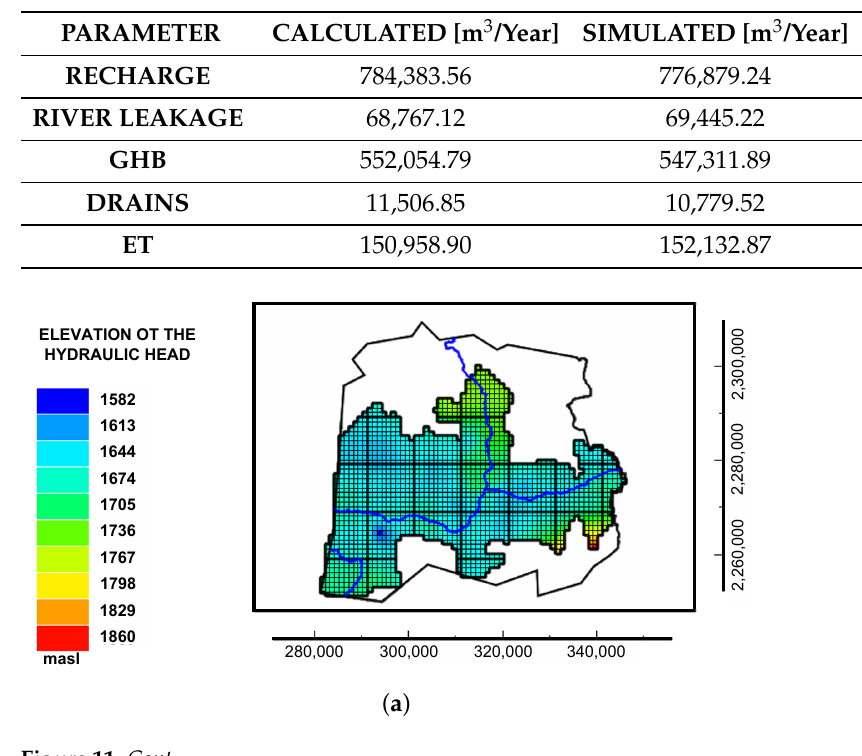
Figura 2.9: Cargas hidr´aulicas en Estado Estacionario de la temporada de Lluvias, donde la mayor carga se representa por el color rojo y la menor carga por el azul oscuro. Figure 11. Cont